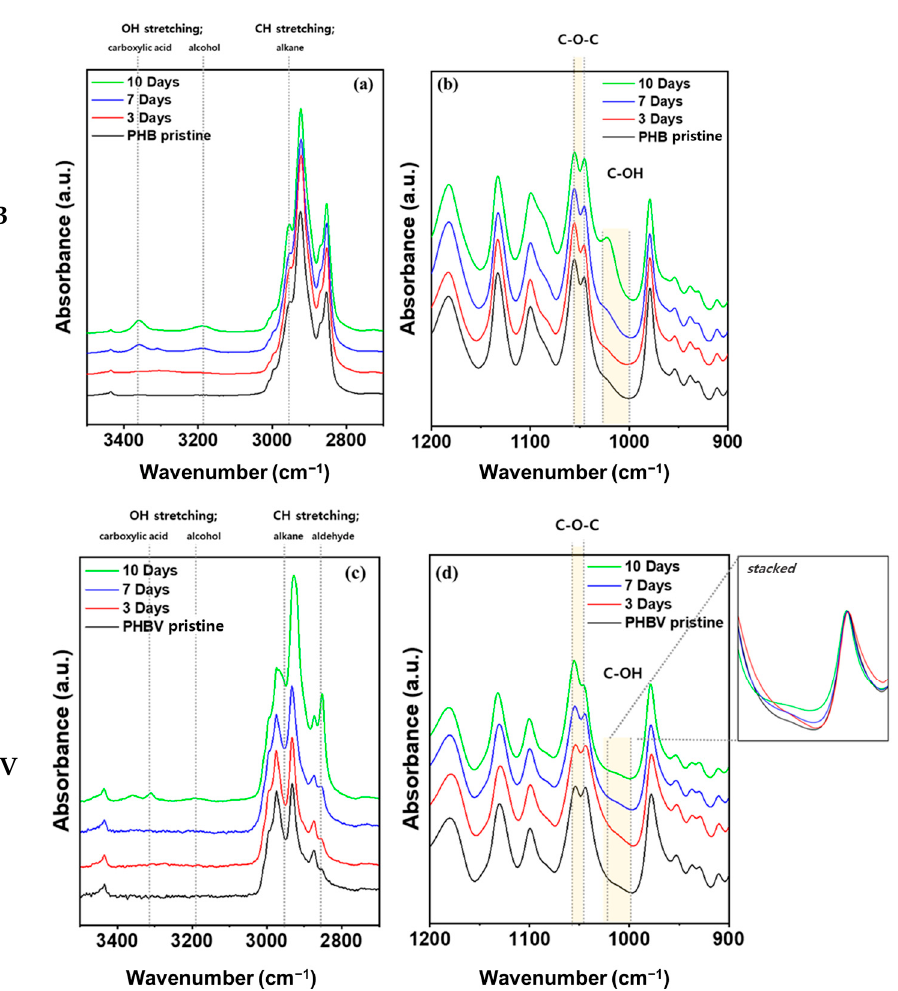
Figure 4. FT-IR of ( a , b ) PHB and ( c , d ) PHBV after being aged in soil fully saturated with water (100% RH).